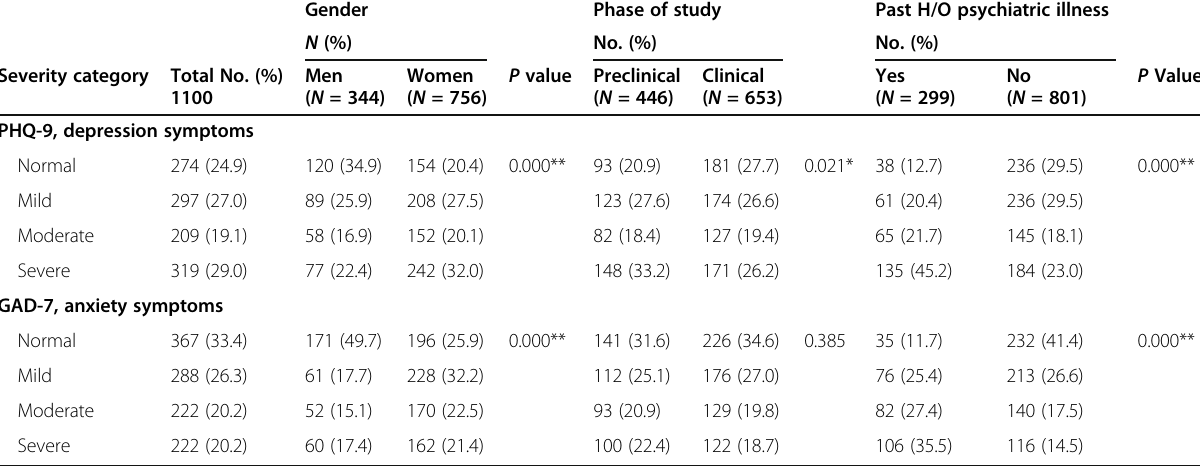
Table 5 Severity categories of depression and anxiety in total cohort and subgroups Gender Phase of study Past H/O psychiatric illness N (%) No. (%) No. (%) Severity category Total No. (%)